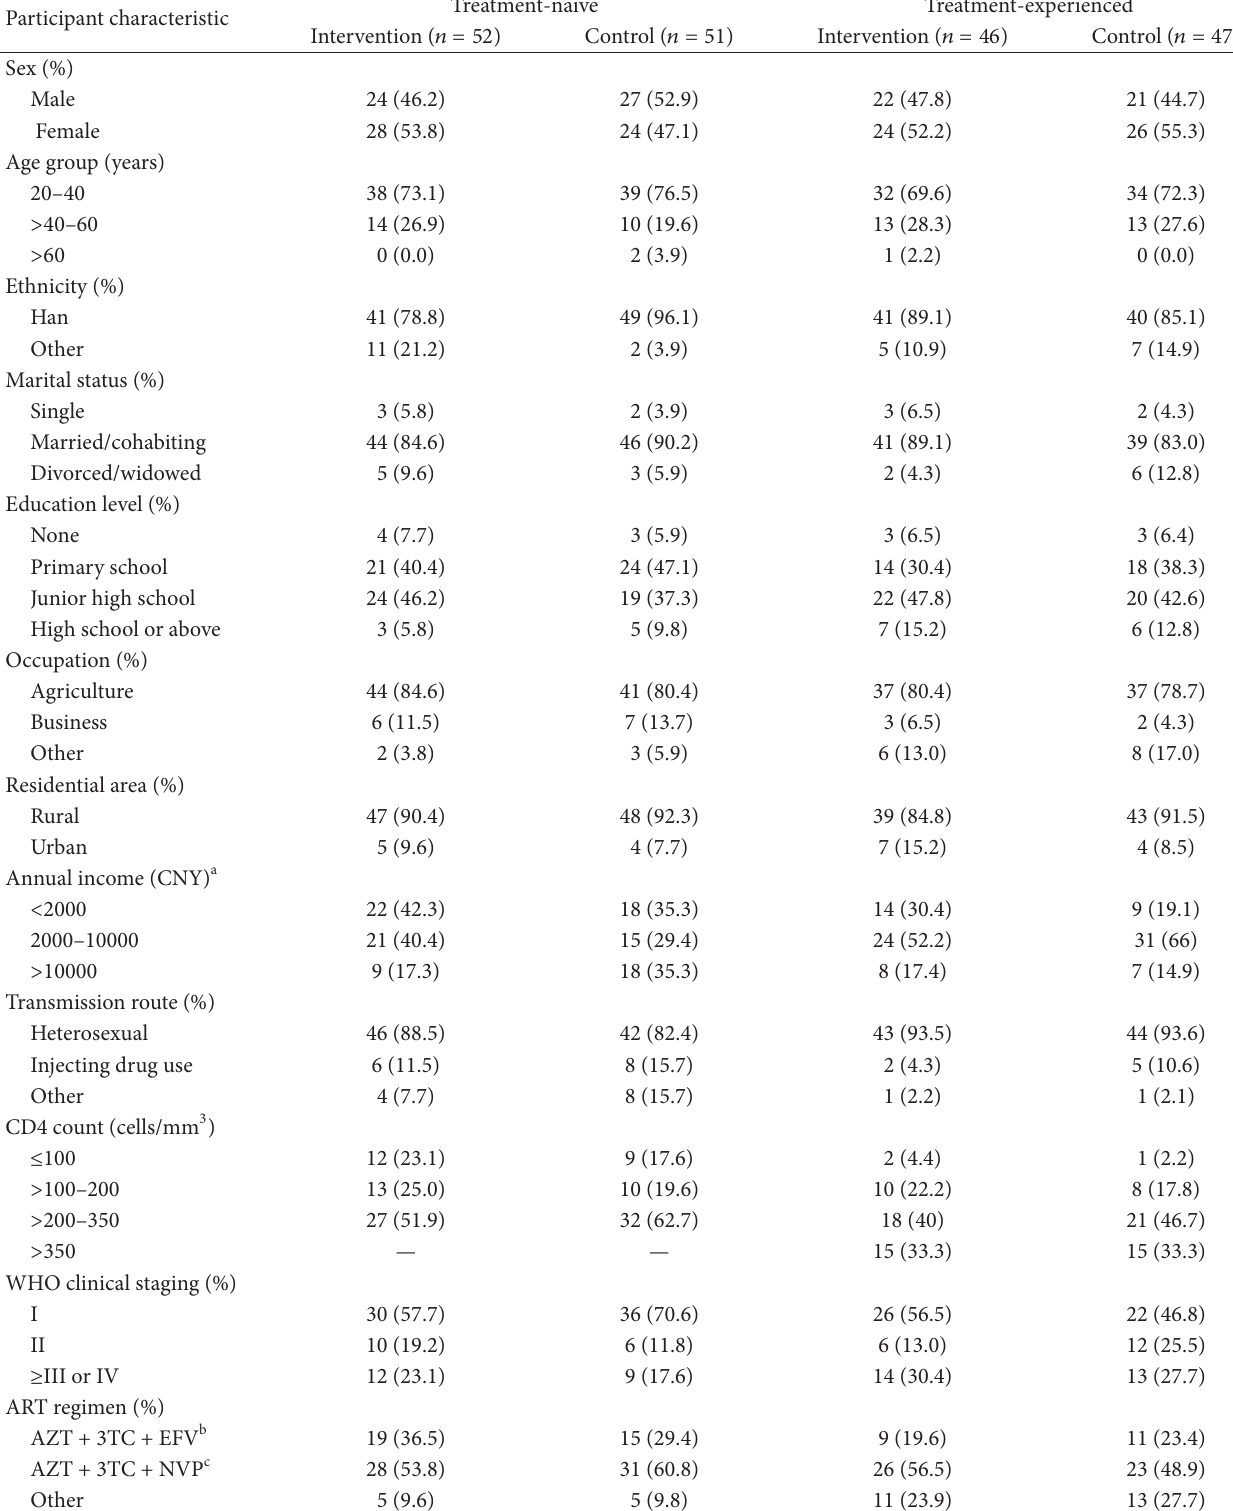
T 1: Baseline characteristics of study participants in intervention and control